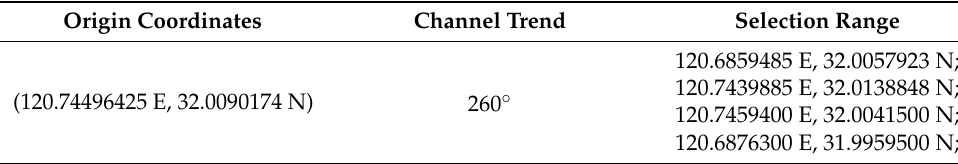
Table 1. Fairway